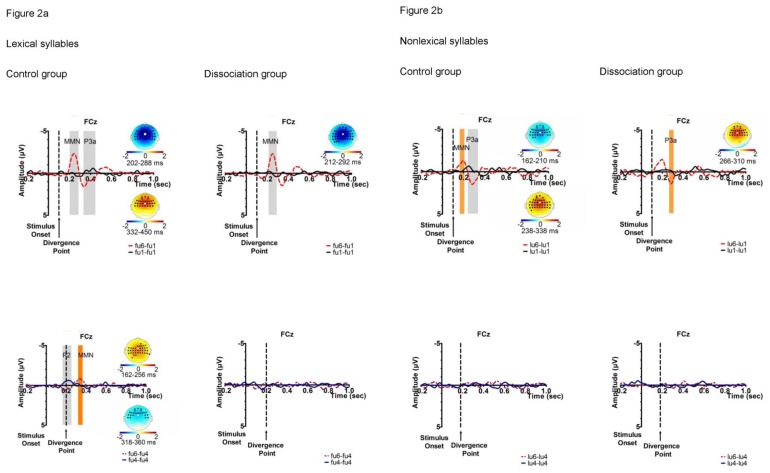
Panel A. Tonal contrasts of lexical syllables. Panel B. Tonal contrasts of nonlexical syllables.
Note. Grand-averaged difference waves and dummy waves at the FCz electrode for illustration, with significant clusters (statistically significant ones in grey and clusters uncorrected for multiple comparisons in orange) considered as MMN or P3a components and their corresponding topographs (significant electrodes in black and FCz in white).